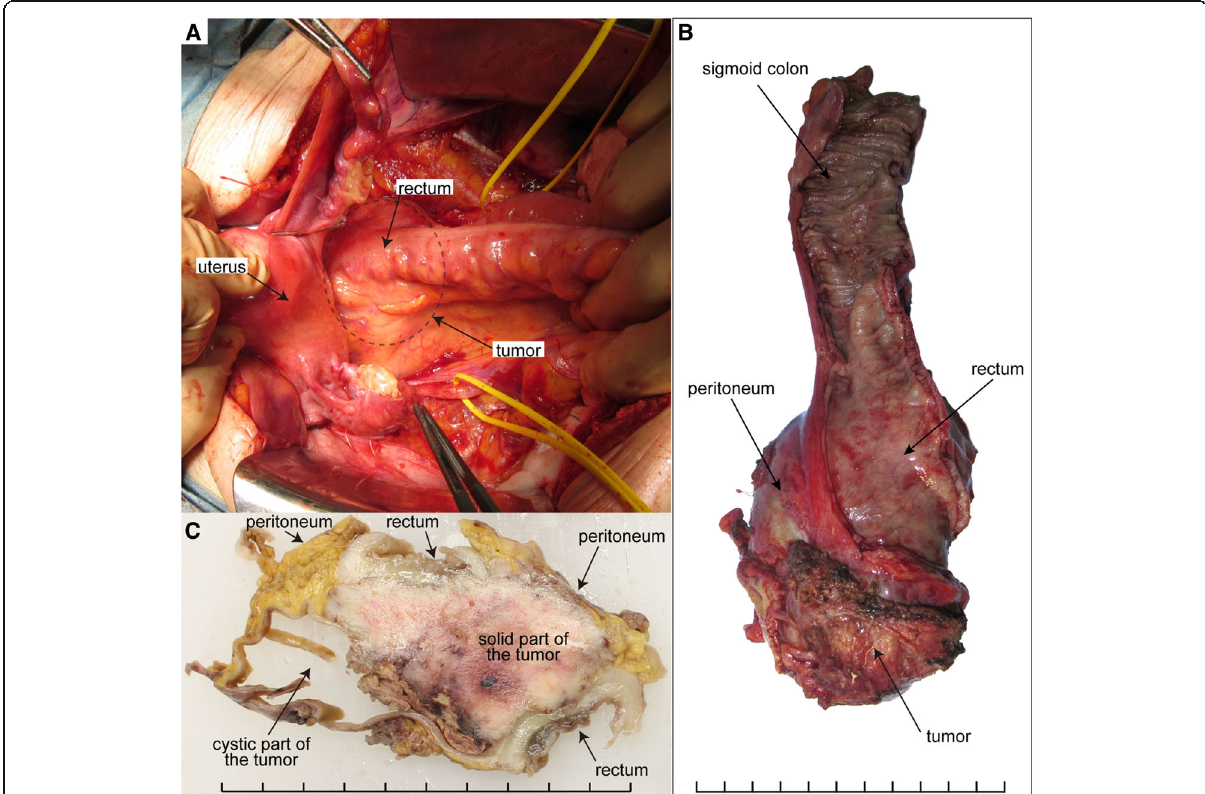
Fig. 2 a Pelvic laparotomy revealed the rectum compressed by the tumor in the mesorectum. The tumor was lying beneath the rectum at the area of dotted circle. Bilateral ureters were marked with yellow tapes. b The retroperitoneal capsuled tumor was resected with the rectum and the part of sigmoid colon. The tumor was surrounded by the rectum as a wrap. c A cross-sectional photograph of the surgical specimen. The tumor was completely separated from the peritoneal cavity with the rectum and peritoneum. Divisions of the scale bar in each panel show one